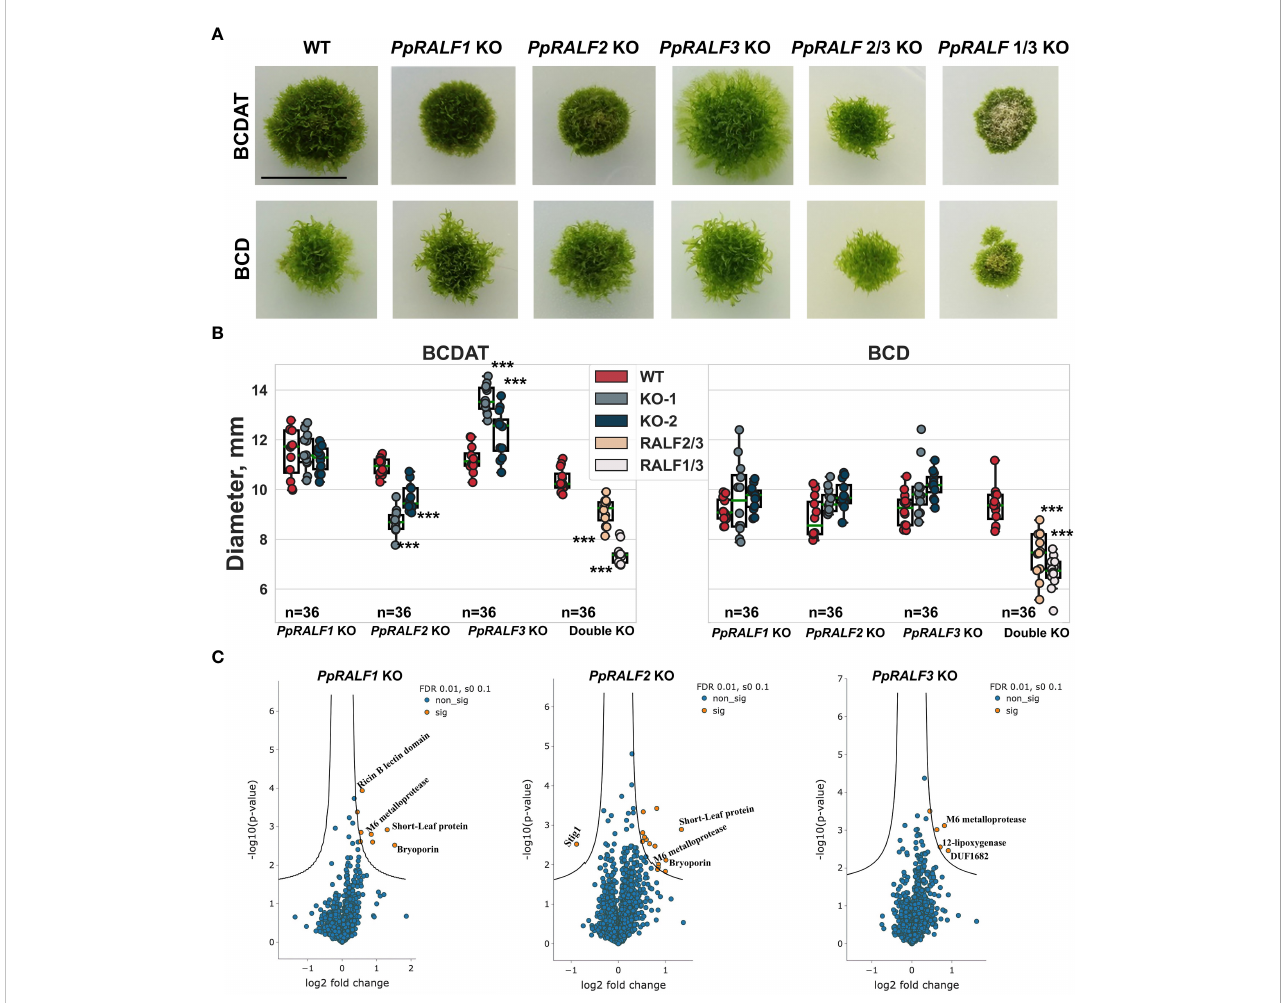
FIGURE 2 (A) Phenotype of 30-d-old plants of wild-type and the obtained knockout lines grown on two mediums with and without ammonium tartrate. Scale bar: 10 mm; (B) Wild-type and knockout lines ’ plant diameters when grown on media containing (BCDAT) and without ammonium tartrate (BCD). For each experiment, the diameters of the wild-type and knockout plants n = 12 for each genotype) are displayed. Analysis of variance and Tukey ’ s HSD post hoc tests were performed *** P < 0.001 (compared to wild-type plants); (C) Volcano plots of the entire set of proteins quanti fi ed during iTRAQ analysis of PpRALF1 , PpRALF2 and PpRALF3 KO lines, respectively. Proteins signi fi cantly changed in abundance are depicted in orange; Pp3c15_830 M6 family metalloprotease domain-containing protein, Pp3c14_22870 SHORT-LEAF protein, Pp3c26_120 bryoporin, Pp3c15_13040 12-lipoxygenase, Pp3c16_14730 Stigma-speci fi c protein, Stig1, Pp3c5_6620 DUF1682, Pp3c3_10250 Ricin B, lectin-containing